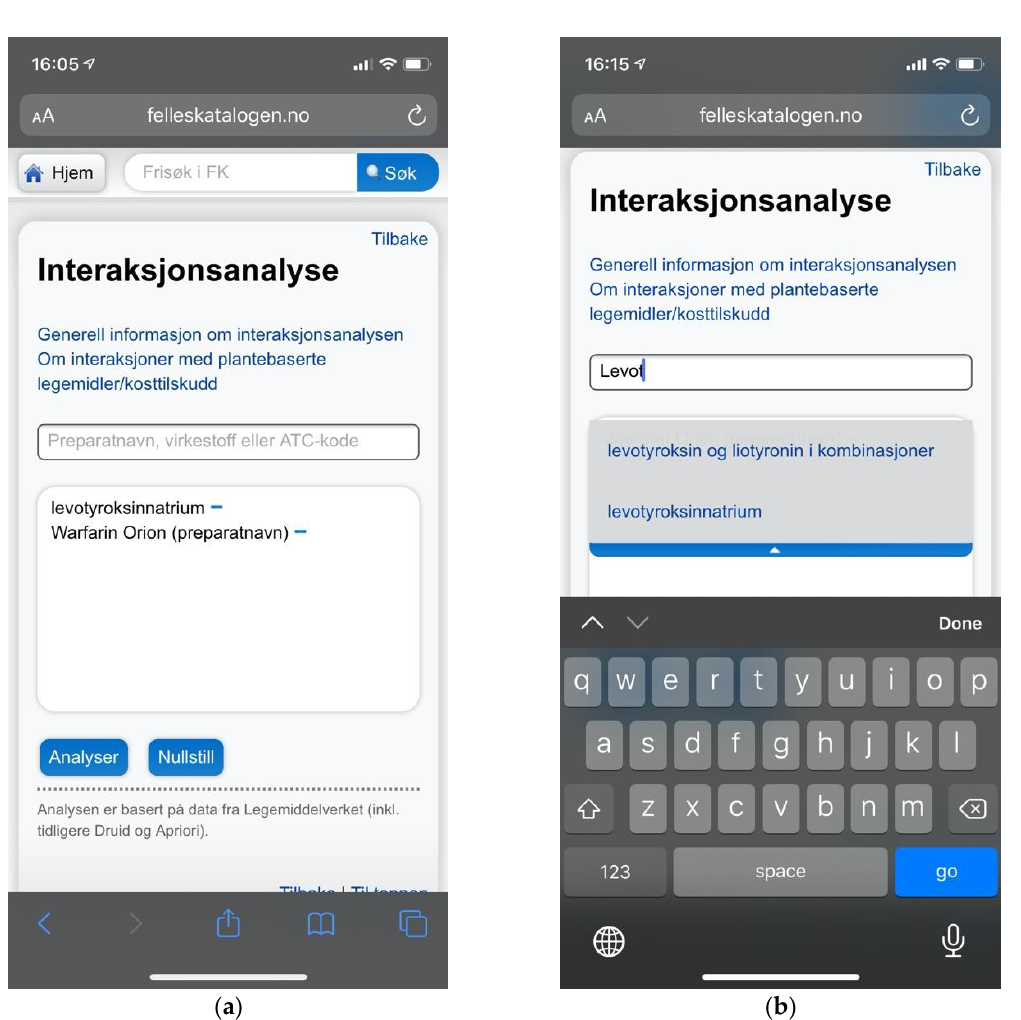
Figure 13. ( a ) Felleskatalogen.no providing a mobile adaptive layout avoiding issues with zoom and viewport handling; ( b ) Felleskatalogen.no did provide search suggestions to help users choose the appropriate search terms.